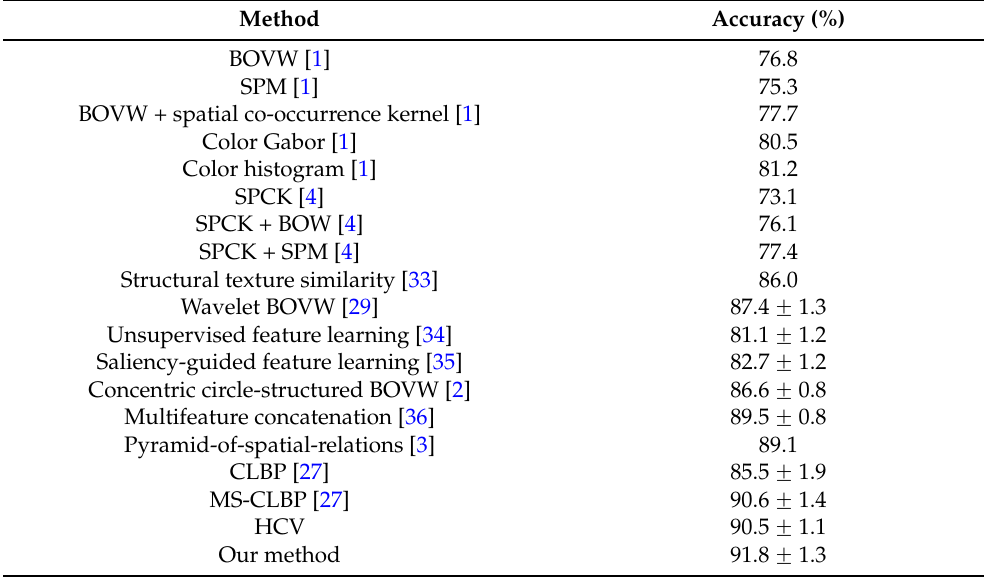
Table 3. Comparison of our approach (FV + HCV) with the state-of-the-art performance reported in the literature on the LU database under the same experimental setup: 80% of images from each class are used for training and the remaining images are used for testing. The average classification accuracy (mean ˘ SD) is set as the evaluation